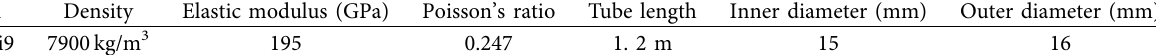
Table 1: Physical parameters of the tube bundle.